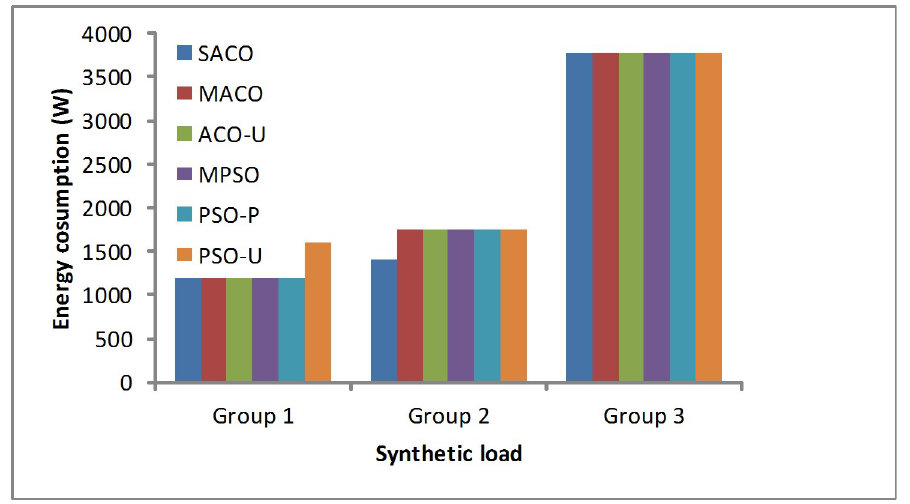
Fig 7. Energy consumption under the synthetic loads.